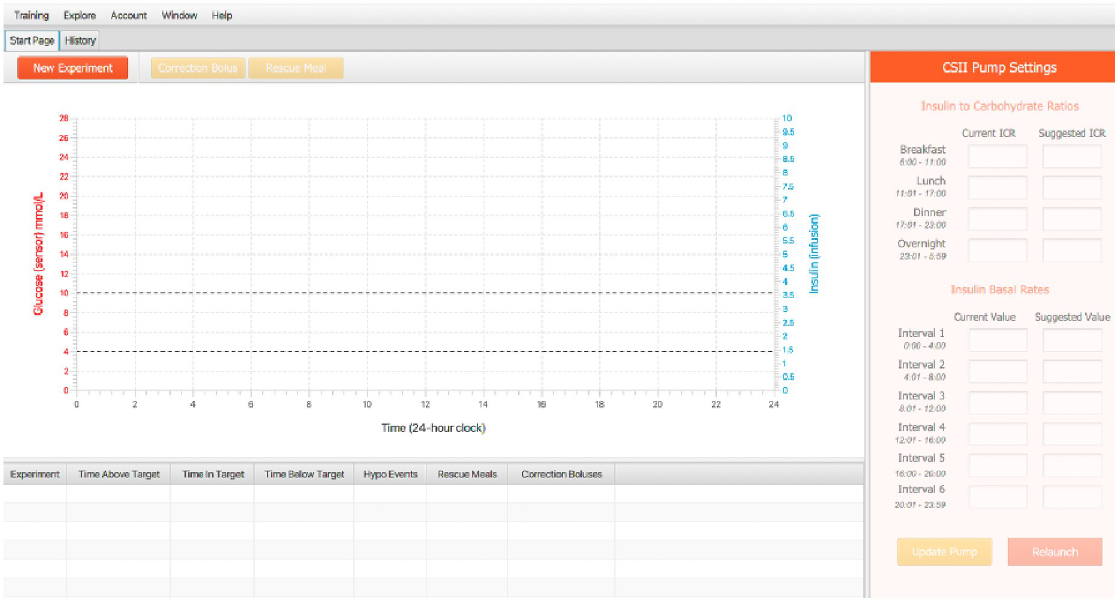
Fig 1. Pump interface view. (Right) Users can specify ICR and insulin basal rate pump settings. (Left) Simulation Results displayed include glucose readings over a 10-minute interval increments and display meal amounts, basal rates, and insulin boluses.